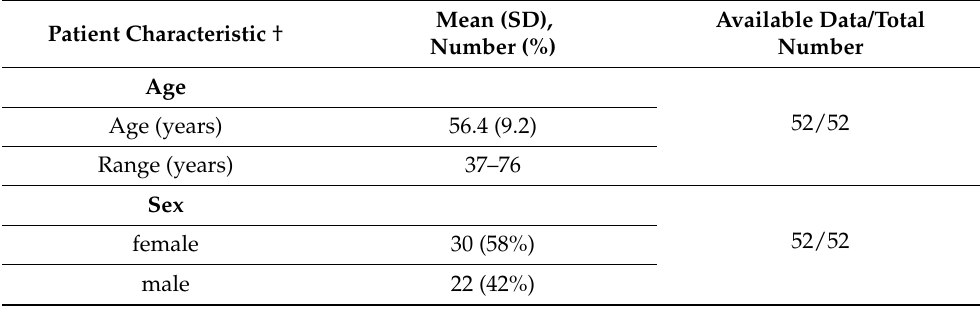
Table 1. Patient